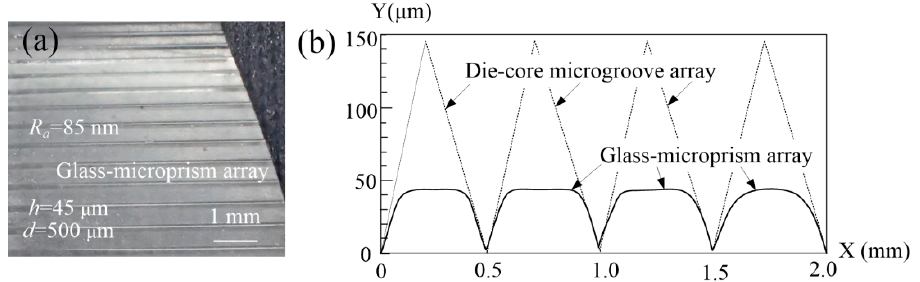
Figure 8. Photograph and profile of glass-microprism array: ( a ) photo of glass-microprism array; ( b ) cross-sectional profile of glass-microprism array (embossing temperature, 630 °C; holding duration, 10 min; embossing force, 0.555 N).